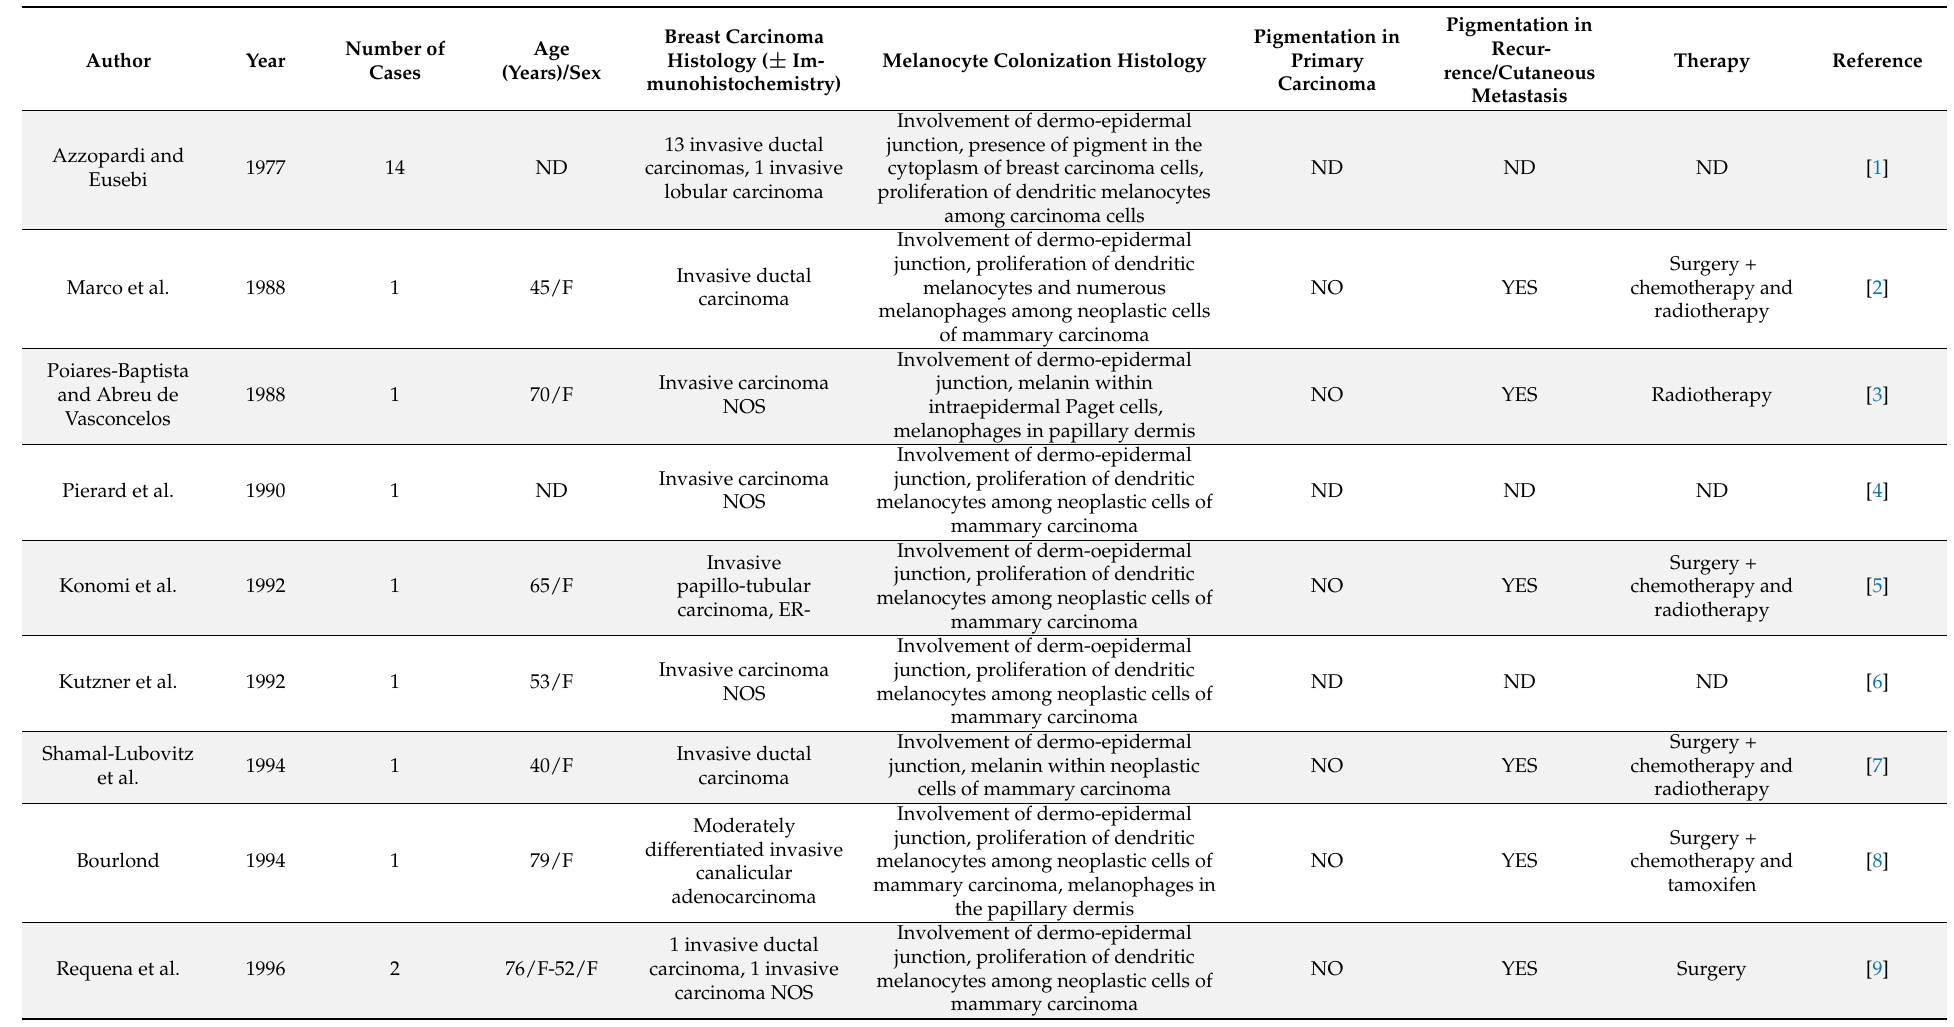
Table 1. Literature regarding melanocyte colonization of breast